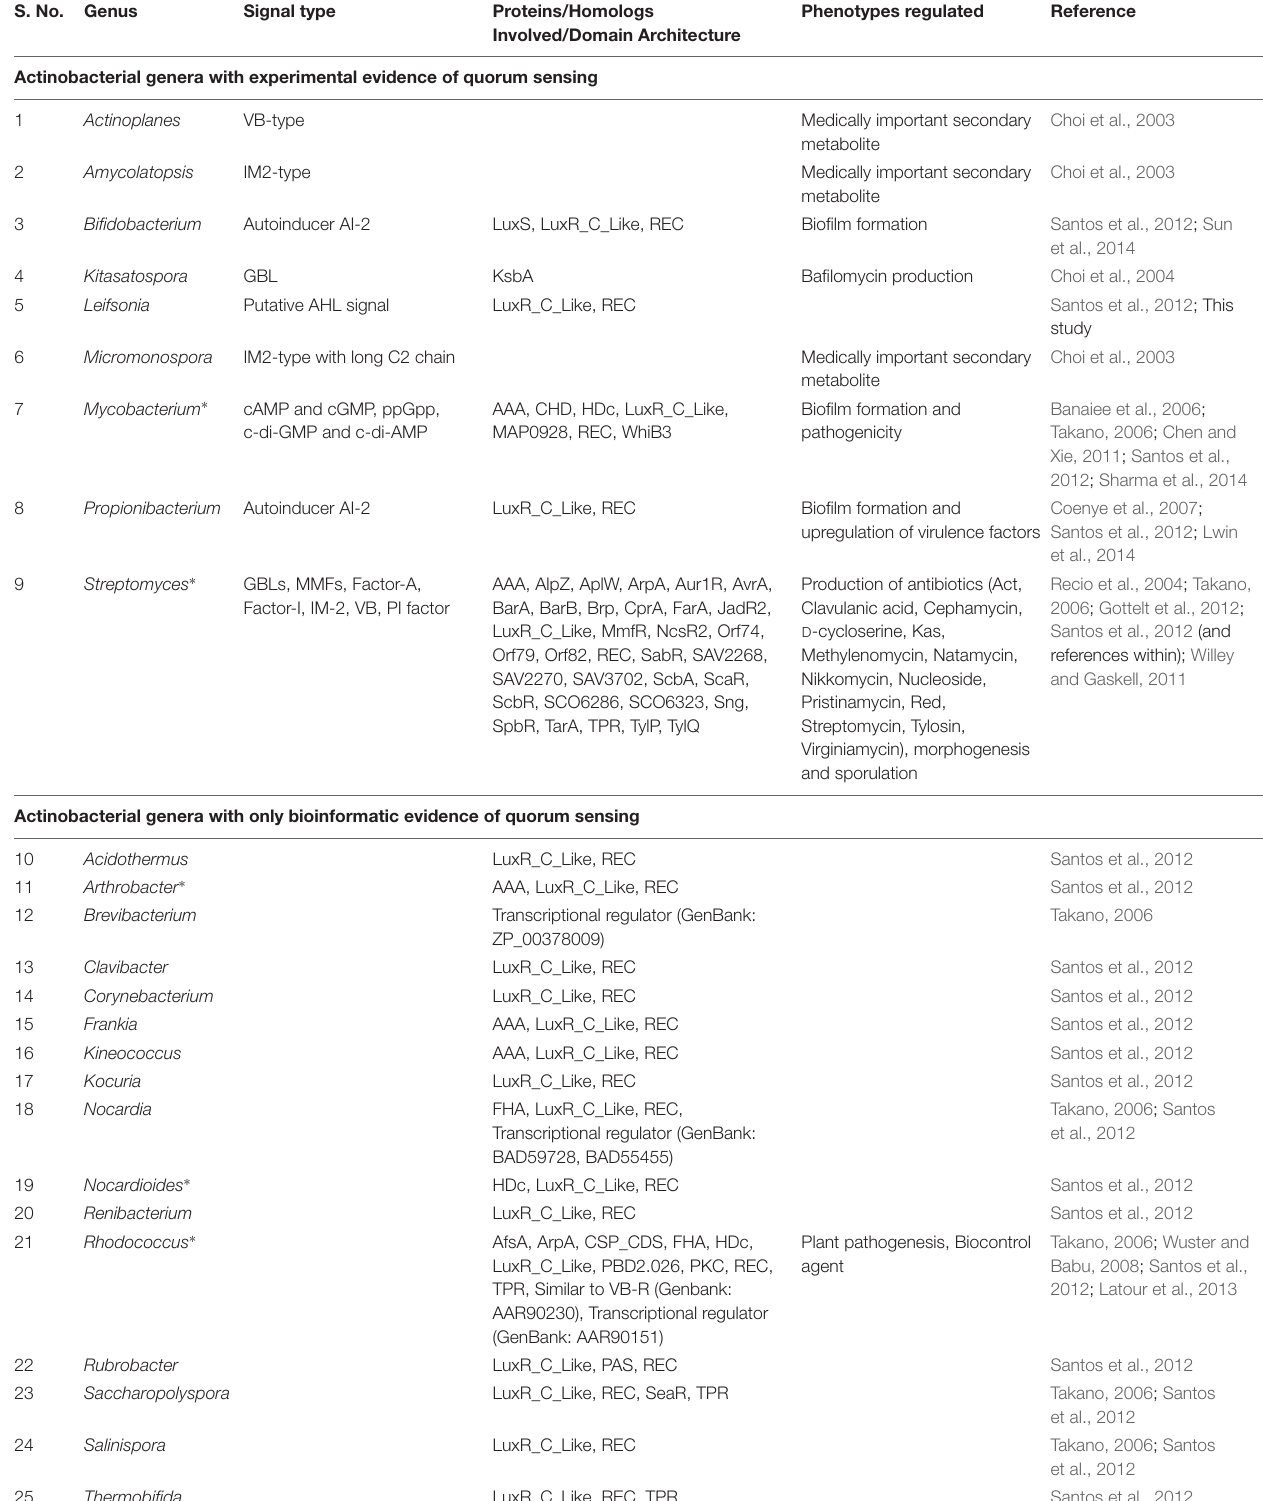
TABLE 1 | Status of quorum sensing systems in Actinobacteria